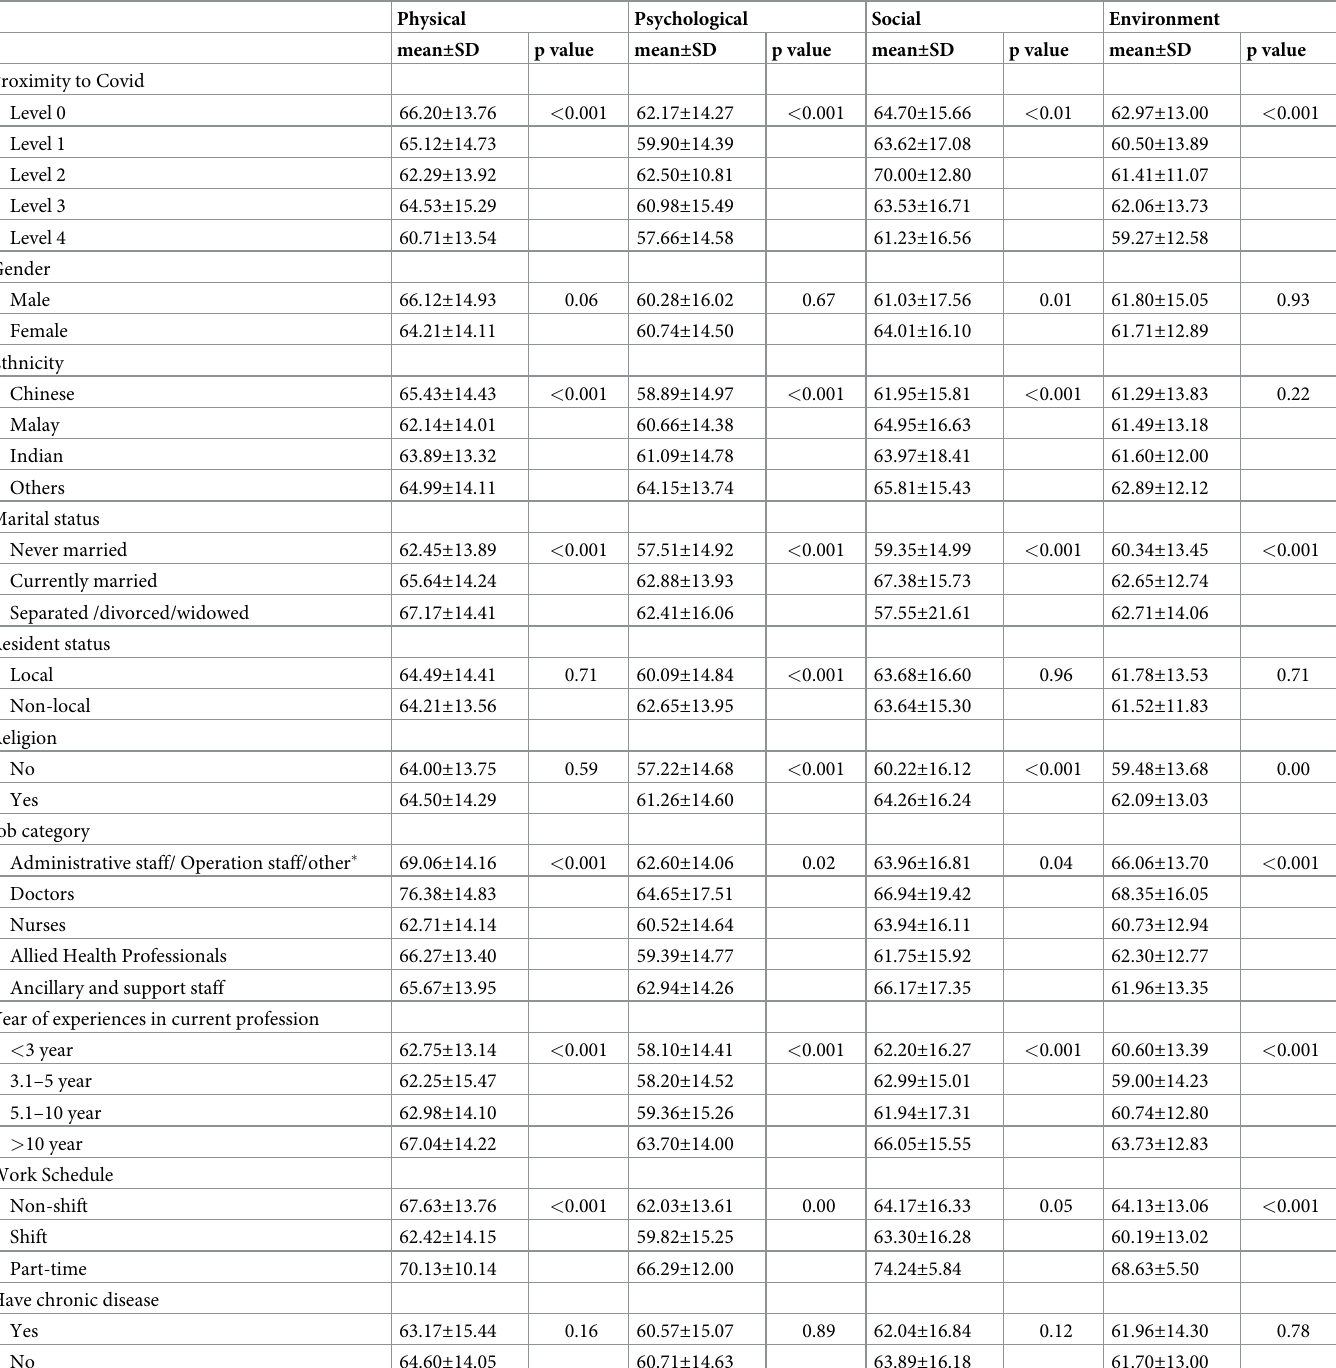
Table 2. Factors associated with QoL (univariate